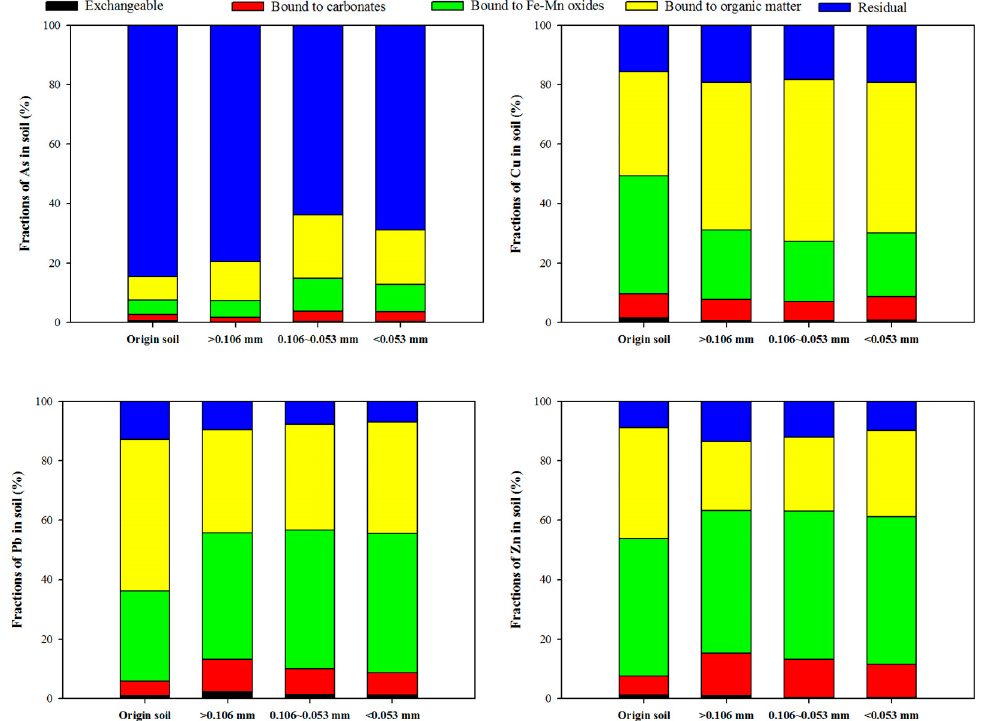
Figure 4. Concentration distribution of copper, lead, and As according to particle size.